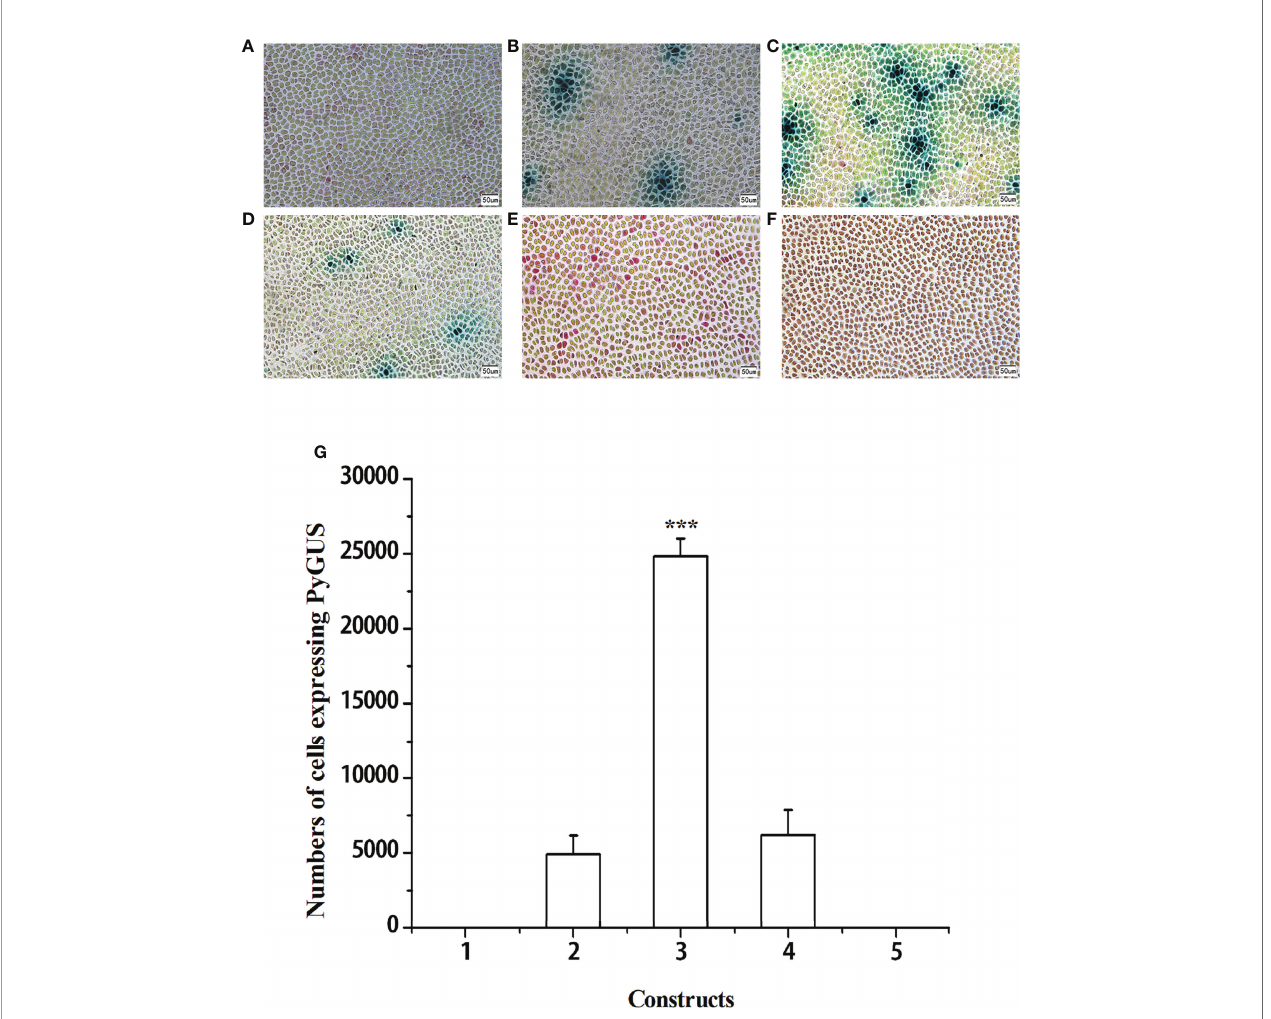
FIGURE 2 | Expression of PyGUS in gametophytic cells of N. yezoensis . Gametophytic cells of N. yezoensis were transformed with expression plasmids PBI121- p PyUBC - PyGUS (A) , PBI121-p PyEF1-a - PyGUS (B) , PBI121-p PyACT1 - PyGUS (C) , PBI121-p PyDPE2 - PyGUS (D) , PBI121-d35S- PyGUS (E) , and without transformation of plasmid (F) . Blue spots indicate cells expressing PyGUS. (G) Comparison of the numbers of cells expressing PyGUS driven by different promoters in N. yezoensis . Plasmids with different promoters used for transformation were as follows: (1) PBI121-p PyUBC - PyGUS , (2) PBI121-p PyEF1-a - PyGUS , (3) PBI121- p PyACT1 - PyGUS , (4) PBI121-p PyDPE2 - PyGUS , and (5) PBI121-d35S- PyGUS . Scale bars indicate 50 m m. Data are expressed as mean ± SD ( n = 3). ***P < 0.001 by analysis of